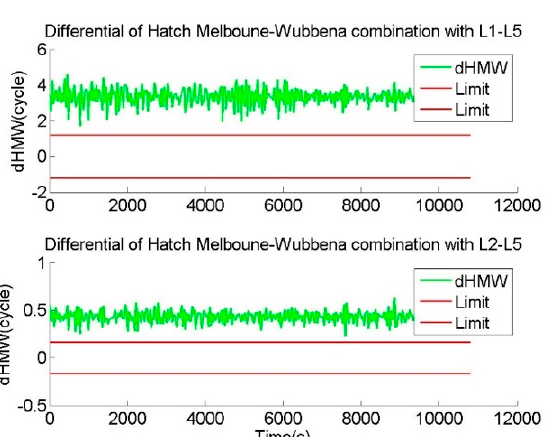
Figure 5. Cycle slip combinations of HMWCSD, where the epoch–difference pseudoranges have been appended with gross errors of 2.5 m epoch by epoch and the phases are without cycle slips on GPS satellite 10 at CUT0 station during the geomagnetic storm that started from UTC 2016/05/08 00:00:00; HMWCSD is the cycle slip detection (CSD) with the Hatch–Melbourne–Wubbena (HMW) combination.